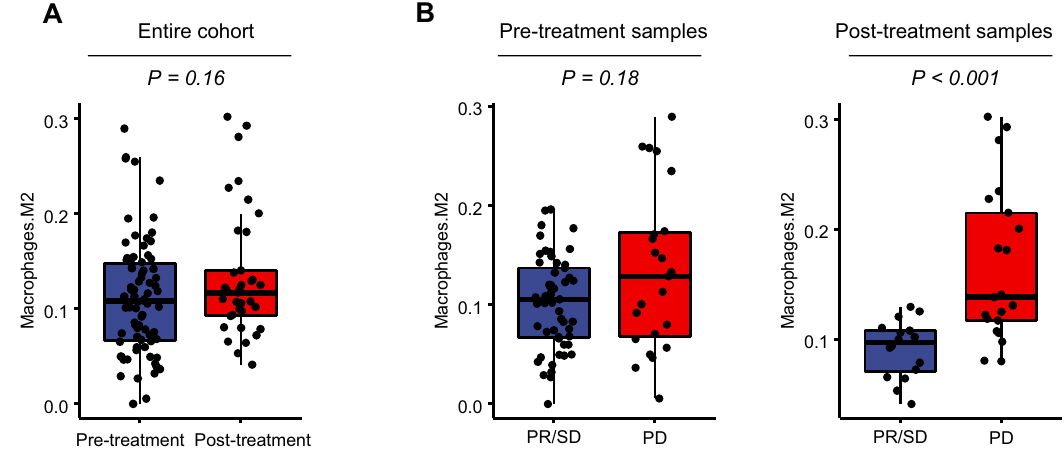
Figure 3. Comparison of the abundance of M2 macrophages estimated by immune deconvolution. The abundance of M2 macrophages estimated by CIBERSORT was compared between pre-treatment versus post- treatment tumor samples in the entire cohort ( A ) and tumors with partial response or stable disease versus those with progressive disease among the post-treatment samples ( B